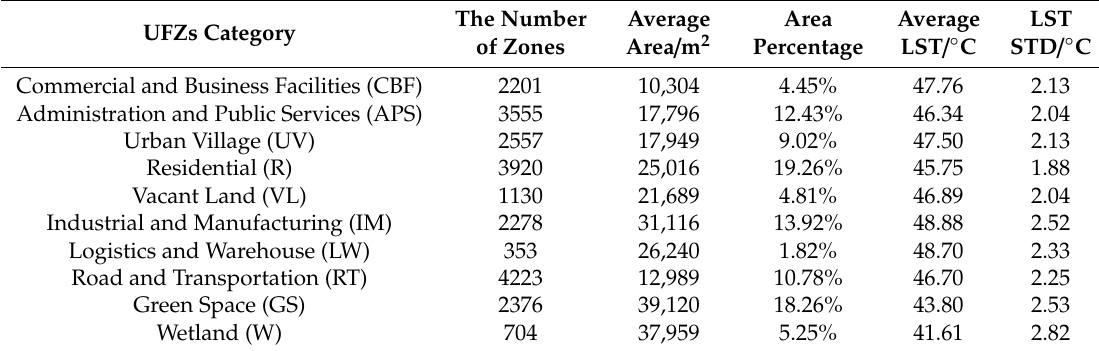
Table 2. The basic information of di ff erent UFZs.